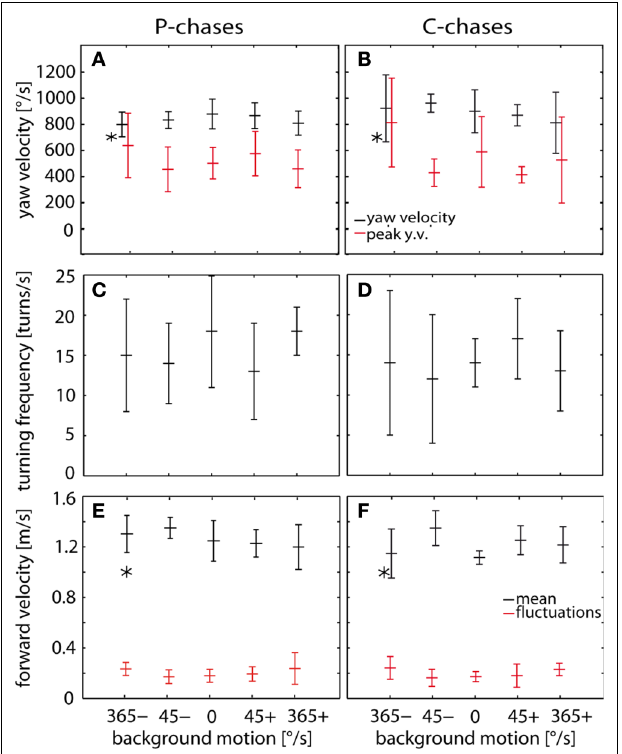
FIGURE 5 | Yaw velocity, forward velocity and turning frequency determined separately for C- and P-chases for fi ve different background conditions: the grating was held stationary as a reference ( 0 ° /s) or the grating either moved slowly ( 45 ° /s) or fast ( 365 ° /s) in the same direction as the target ( positive sign ) or in the opposite direction to the target ( negative sign ). (A,B) Time-averaged ( ± SD) yaw velocity ( black ) and mean ( ± SD) deviation peaks from average yaw velocity ( red ) determined for P-chases (A) and C-chases (B) . The target moved at 700 ° /s ( asterisk ). (C,D) Time-averaged ( ± SD) forward velocities ( black ) and the average ( ± SD) velocity fl uctuations ( red ) determined for P-chases (C) and C-chases (D) . The fl ies followed the target that moved at 1 m/s ( asterisk ). (E,F) Overall average ( ± SD) turning frequency determined for P-chases (E) and C-chases (F) . Mean and standard deviation were calculated across fl ies. 0 ° /s: C-chases n = 7, total fl ight time (TFT) = 1896 ms; P-chases n = 10, TFT = 2844 ms. + 45 ° /s: C-chases n = 7, TFT = 2288 ms; P-chases n = 8, TFT = 2492 ms. − 45 ° /s: C-chases n = 4, TFT = 748 ms; P-chases n = 8, TFT = 3912 ms. + 365 ° / s: C-chases n = 9, TFT = 2788 ms; P-chases n = 7, TFT = 3108 ms. − 365 ° /s: C-chases n = 9, TFT = 2928 ms; P-chases n = 9, TFT = 4024